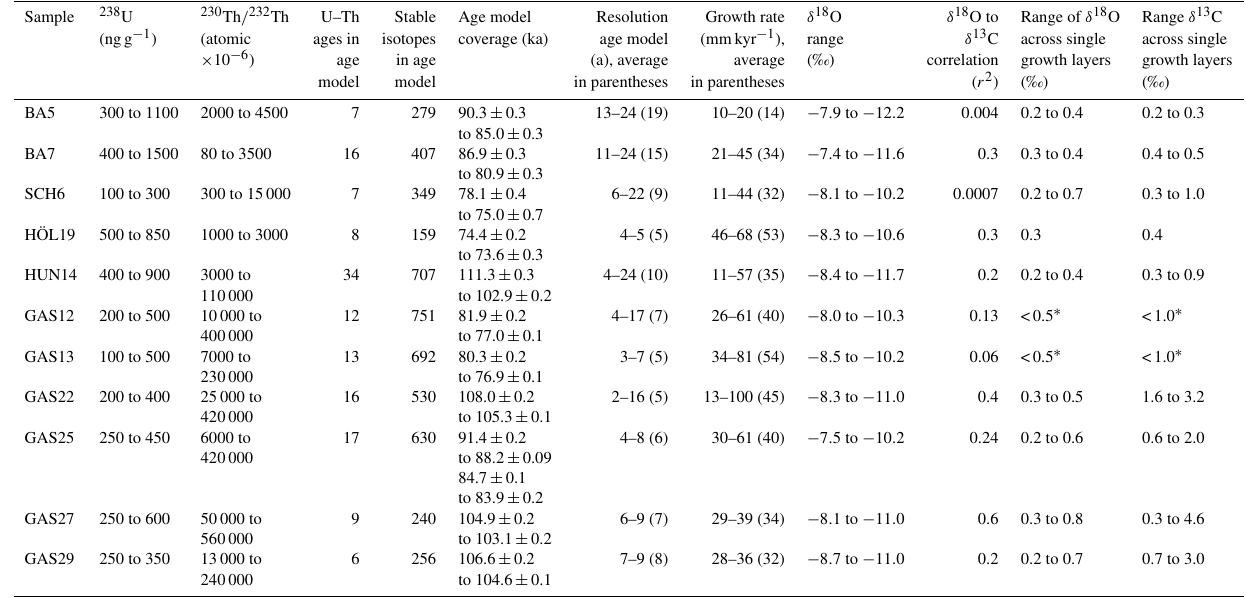
Table 2. Summary of the key features of the U–Th measurements, age modelling, and tests for isotopic equilibrium as presented in Tables S1 and S2, and Figs. S3 and